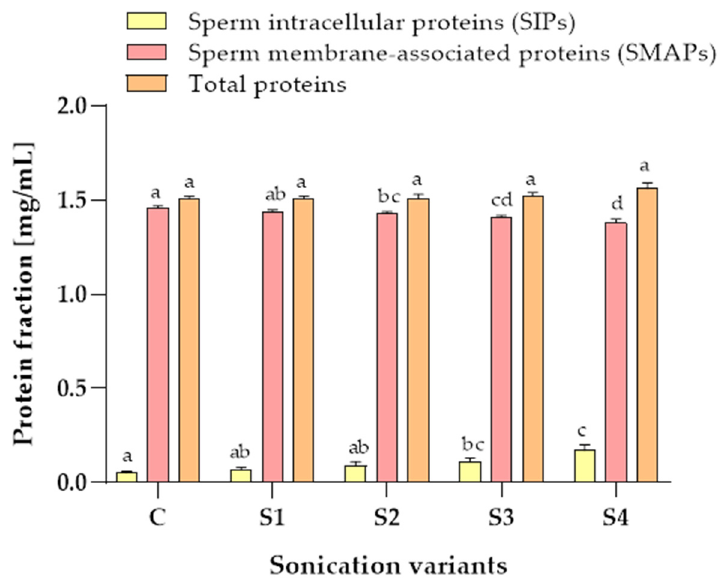
Figure 3. Average amounts of intracellular proteins (SIPs) and membrane-associated proteins (SMAPs) (mg/mL) of dog ( Canis lupus familiaris ) cauda epididymal spermatozoa (n = 15) obtained using different sonication variants. C—control sample (without sonication), the S1—5 min, 50 W; S2—10 min, 50 W; S3—30 min, 50 W; S4—10 min, 150 W. Values are presented as the mean ± SE. Different sonication variants were compared with their respective control each by each. Different letters indicate significant difference ( p ≤ 0.05).